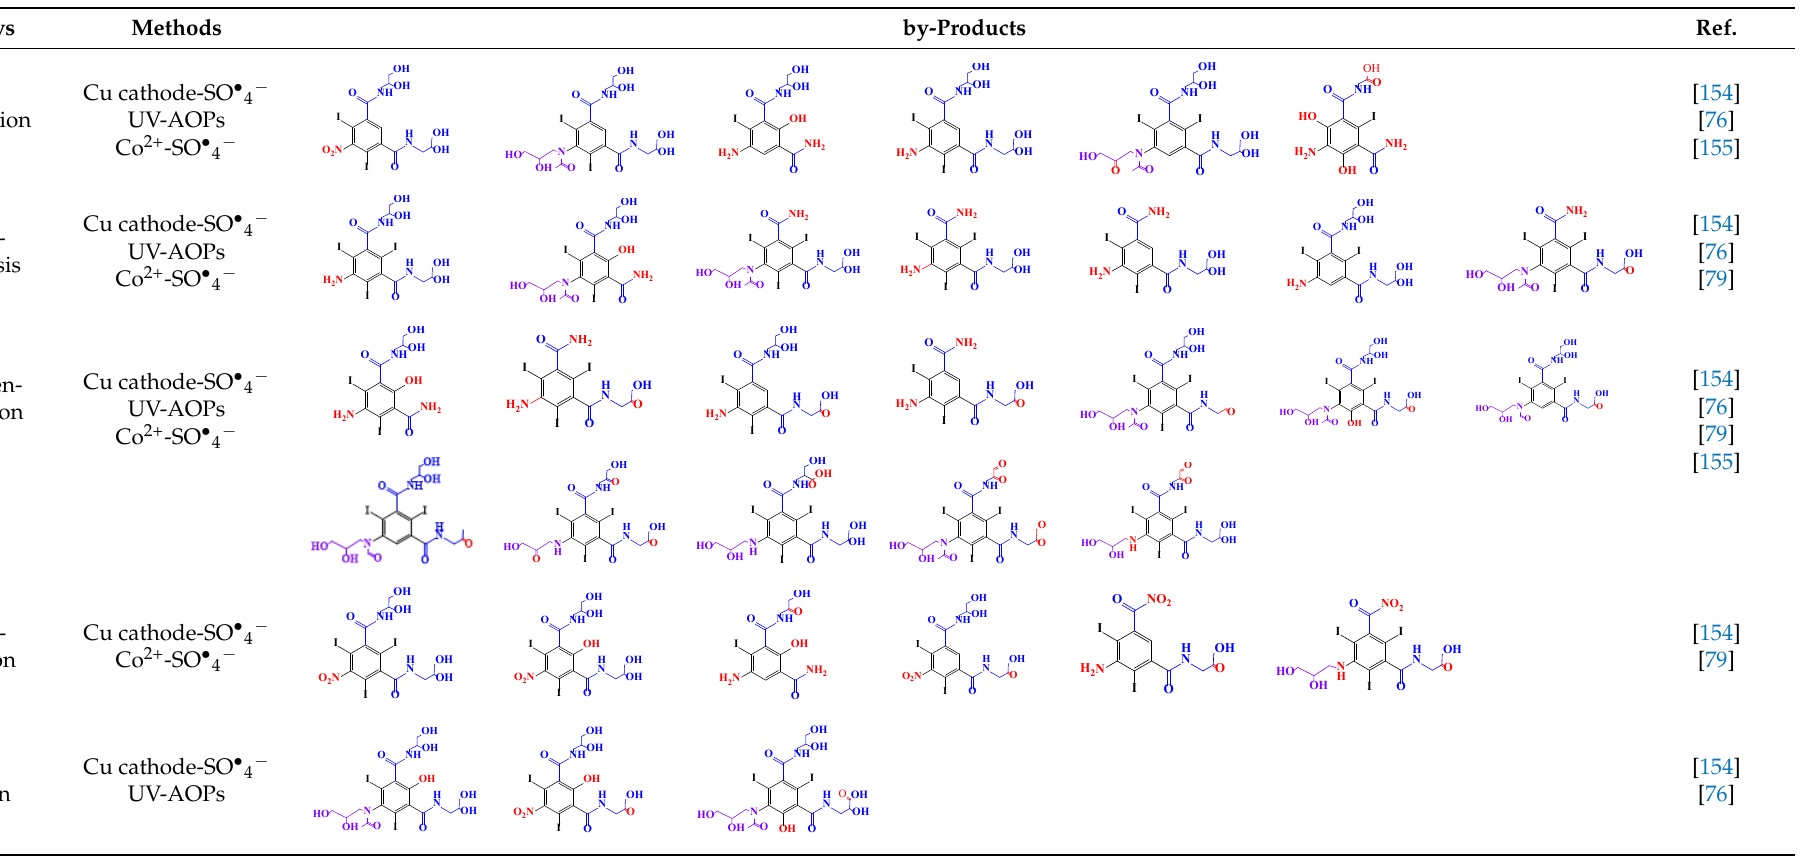
Table 6. Identified by-products of iohexol in recent literature.